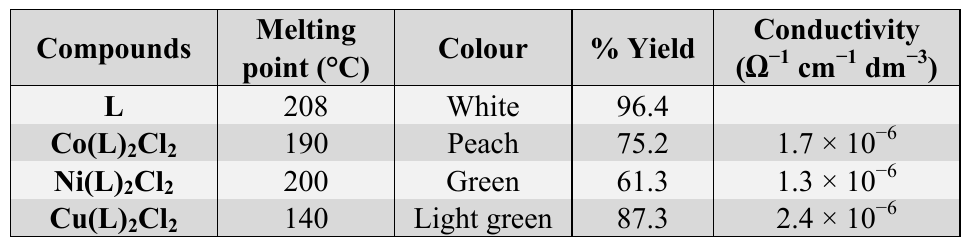
Table 4. Physical properties of L and its metal